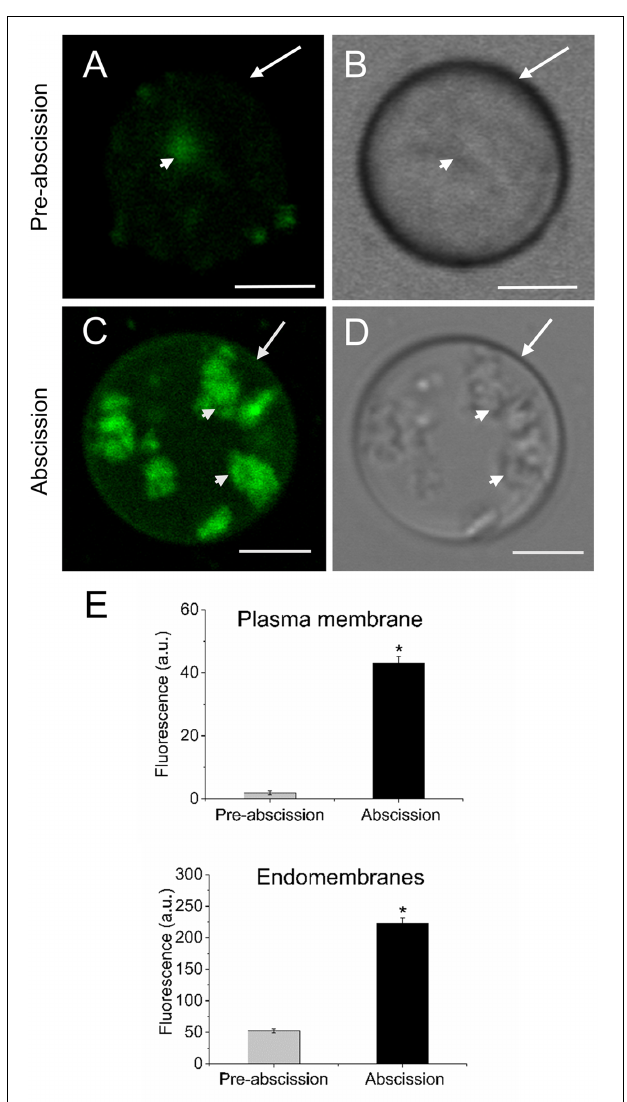
FIGURE 3 | Changes in the sphingolipid content in live protoplasts from olive AZ during mature-fruit abscission. (A) BD-SM stained protoplast from the olive AZ at the stage pre-abscission compared to the white-light image (B) . (C) BD-SM stained protoplast from the olive AZ at the stage abscission compared to the white-light image (D). (E) Quantification of BD-SM fluorescence in the plasma membrane and the intracellular membranes of live protoplasts from olive fruit AZ at different stages during abscission. About 10 protoplasts were acquired for each sample, and data were obtained with FV10 4.2 software (Olympus). Columns and bars indicate means ± SD, respectively, from five independent experiments. Statistically significant differences based on unpaired Student’s t -test at P < 0.05 are denoted by asterisk. Scale bars are 5 µ m. Arrow: plasma membrane. Arrowhead: